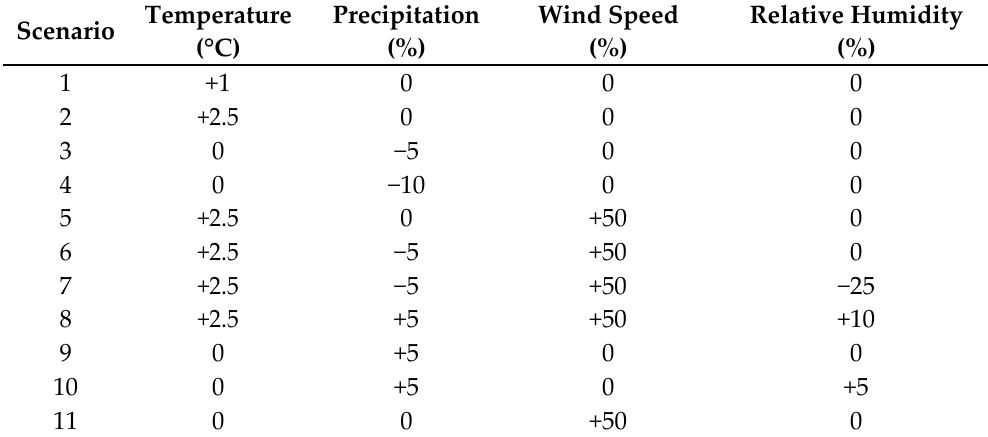
Table 1. The hypothetical climate scenarios.